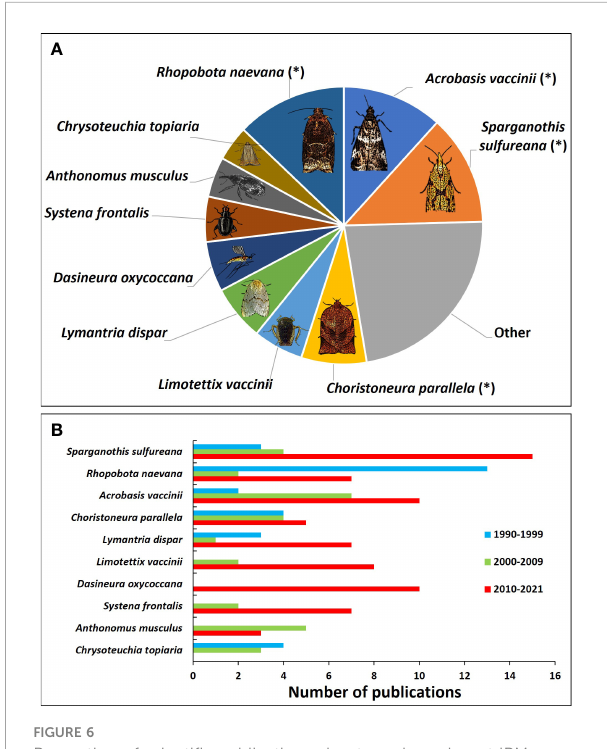
FIGURE 6 Proportion of scienti fi c publications about cranberry insect IPM published by insect species (A) and the amount of papers about insects over each of the past three decades (B) . Of the most studied insect pests, blackheaded fi reworm ( Rhopobota naevana ), Sparganothis fruitworm ( Sparganothis sulfureana ), and cranberry fruitworm ( Acrobasis vaccinii ) are the top three, at 12.9%, 12.9%, and 11.7% respectively. (*) denotes a direct pest, which injures the marketable